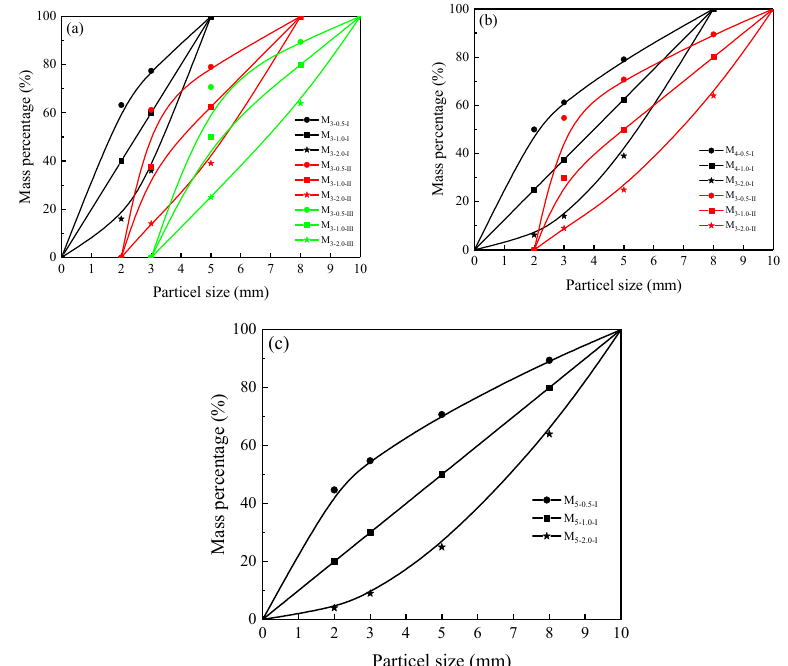
Figure 3. Particle size distribution (PSD) in cemented rock samples. ( a ) S 3 series (3 component rock mixture); ( b ) S 4 series (4 components); ( c ) S 5 series (5 components). Mass percentages are cumulative, showing total mass below the indicated size.